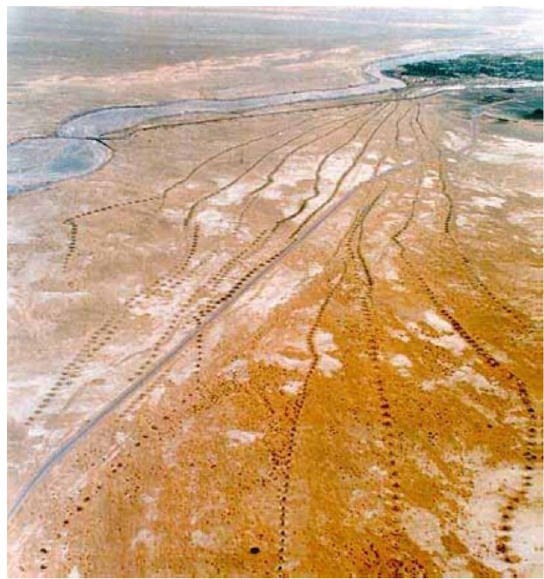
Fig. 8 Photo of the khettara system in the Tafilalet Valley (Source: www. Water histo ry.